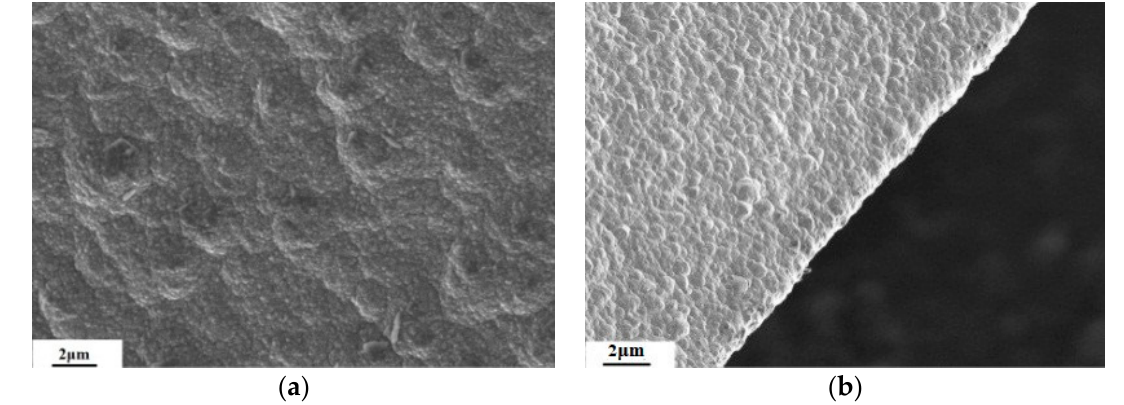
Figure 3. Morphology of MCD/NCD coated tool. ( a ) Tool surface; ( b ) cutting edge.